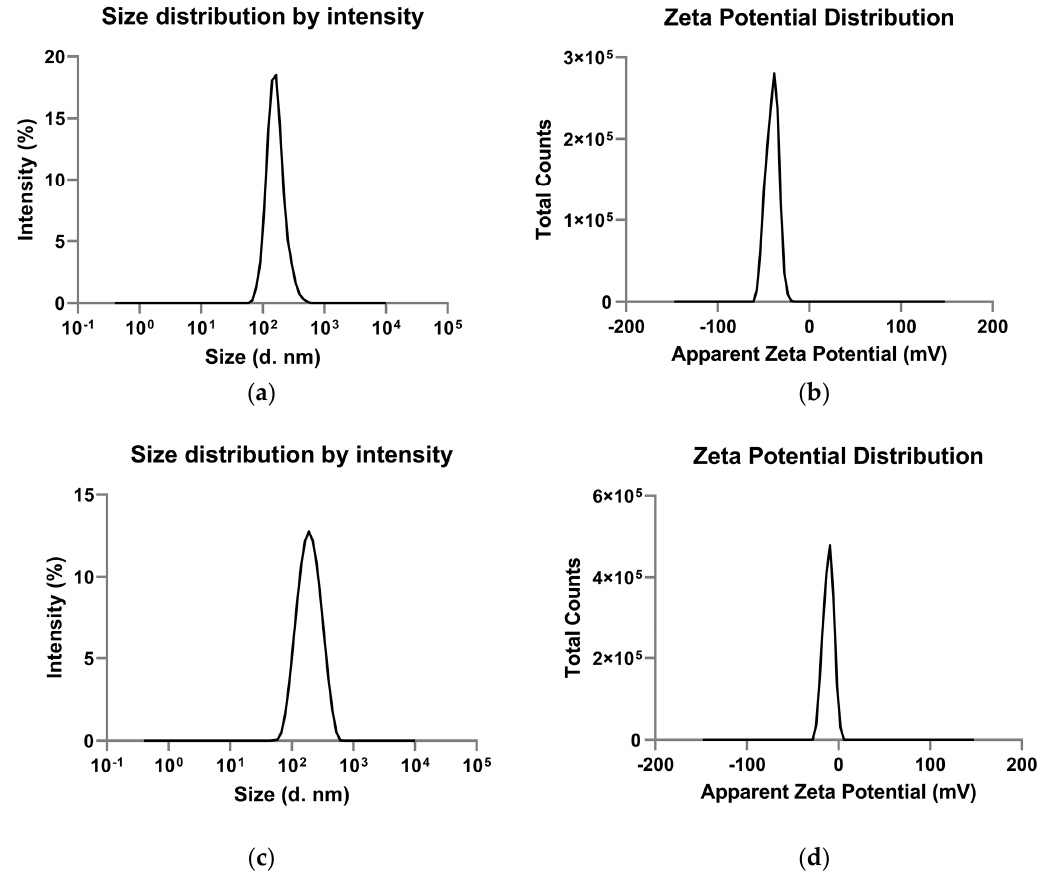
Figure 1. Particle size distribution and zeta measurement profile of native ( a,b ) and vascular endothelial growth factor-conjugated poly-lactic-co-glycolic acid nanoparticles (VEGF-PLGA-NPs) ( c,d ). Data are three different measurements made by the instrument on the same sample. ( a ) Size distribution of PLGA-NPs; ( b ) zeta potential distribution of PLGA-NPs; ( c ) size distribution of VEGF-PLGA-NPs; ( d ) zeta potential distribution of